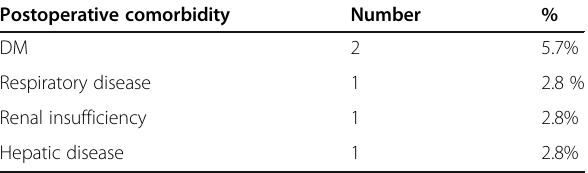
Table 4 Postoperative comorbidity Postoperative comorbidity